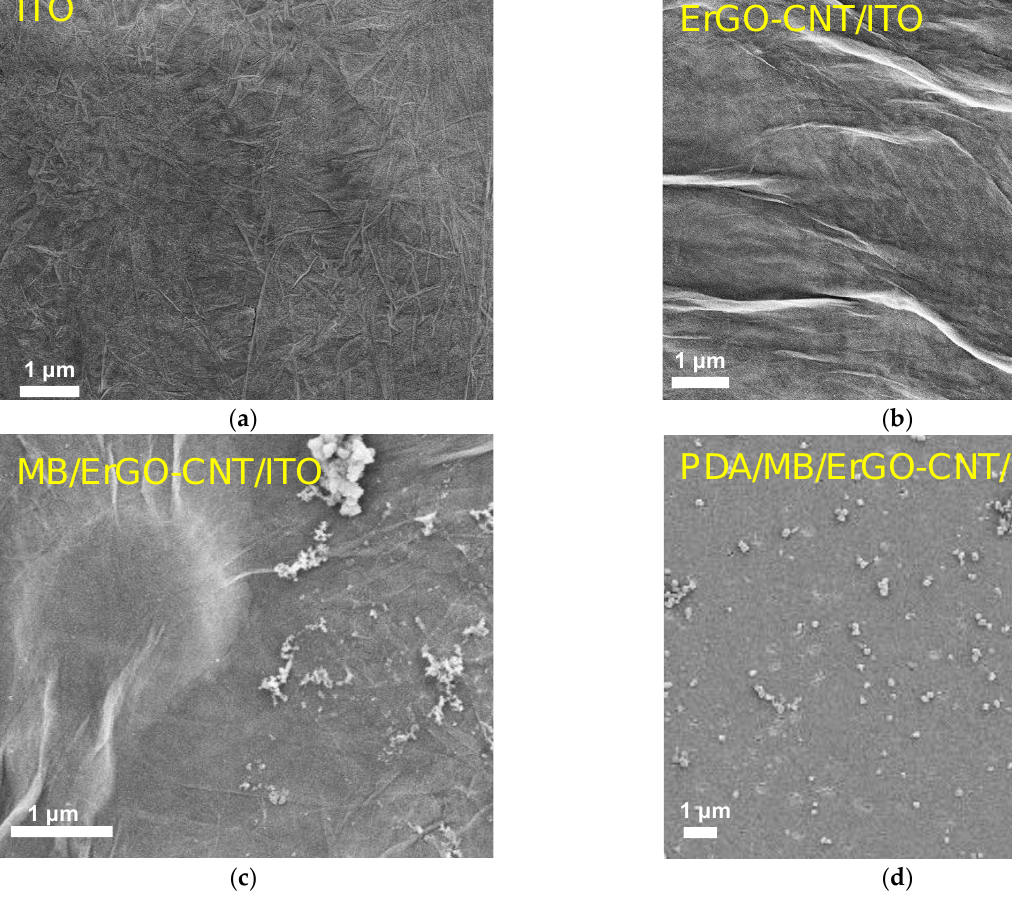
Figure 4. Top-view SEM images of bare ITO ( a ), ErGO-CNT/ITO ( b ), MB/ErGO-CNT/ITO ( c ), and PDA/MB/ErGO-CNT/ITO ( d ) electrodes.